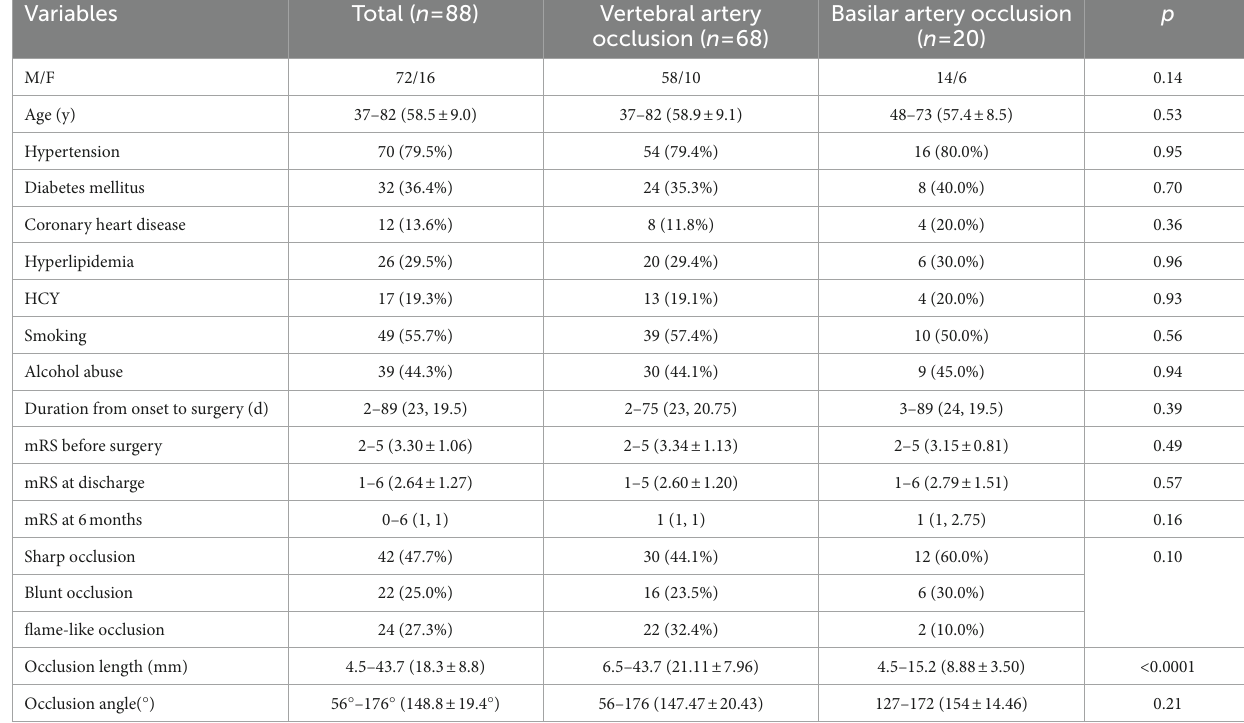
TABLE 1 Clinical data of